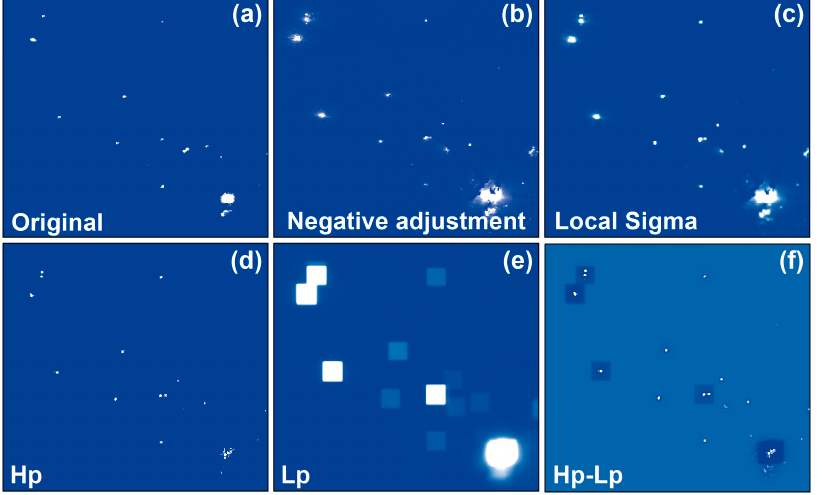
Figure 2. Data preprocessing: ( a ) is the original image; ( b ) is the negative adjustment image; ( c ) is the local sigma filtered image, the window size is 3 × 3, sigma factor is 4; ( d ) is the Hp image, convolution kernel is 3 × 3; ( e ) is the Lp image, convolution kernel is 27 × 27; and ( f ) is the difference between the Hp image and the Lp image.